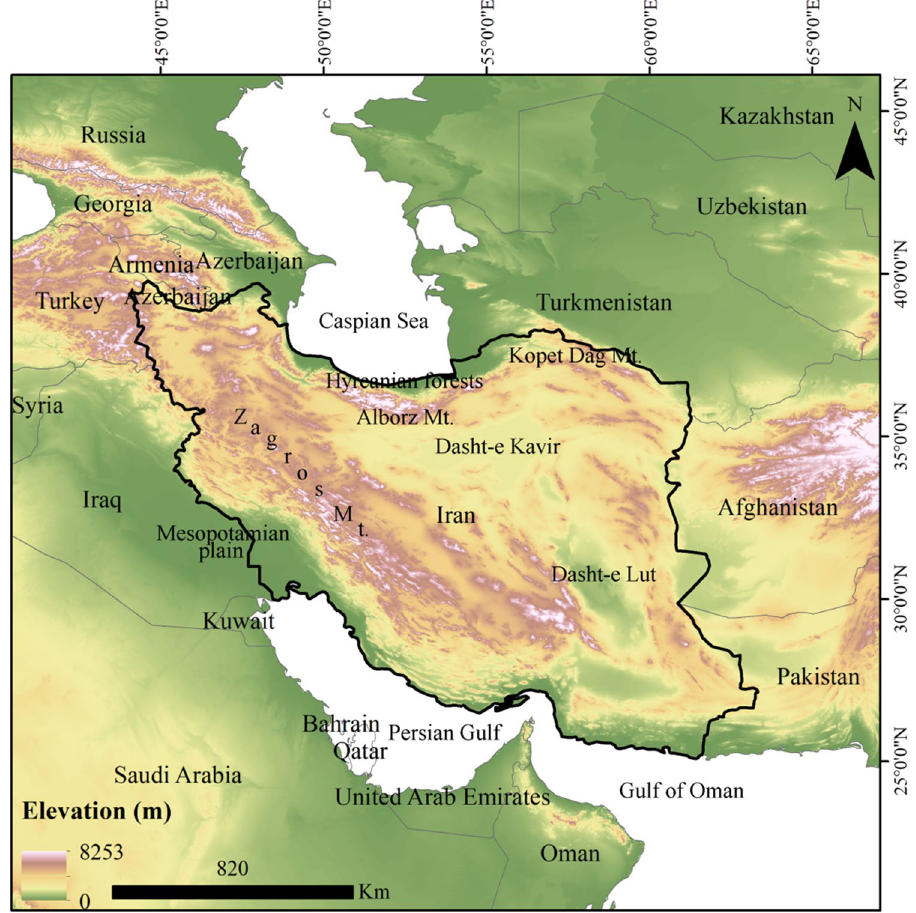
Figure 1. Study area. Iran. Map was generated using ArcMap (v 10.8) (https:// deskt op. arcgis.